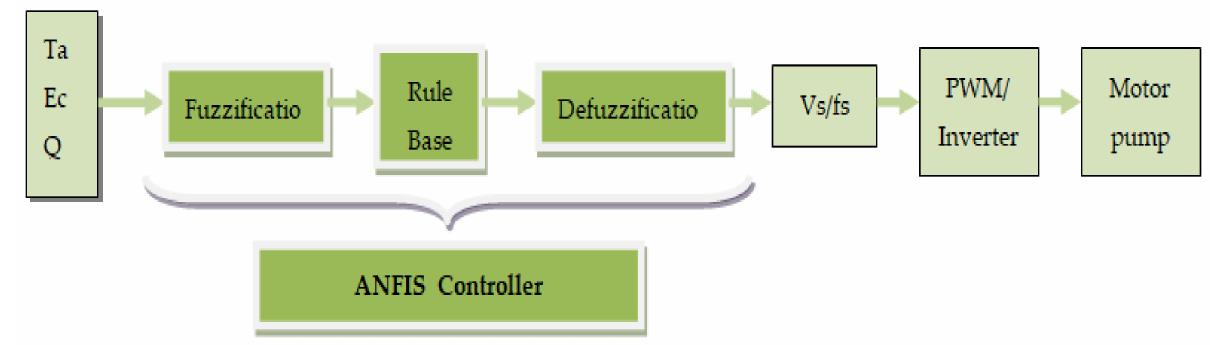
Figure 12. Block diagram control with